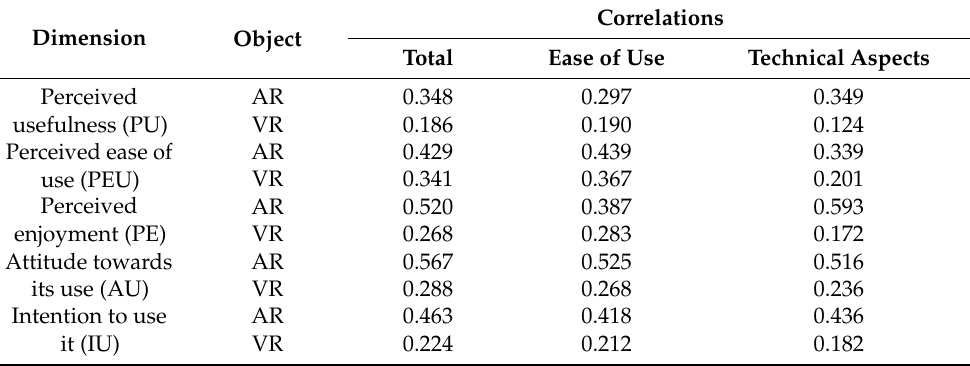
Table 12. Pearson’s correlation coefficient between the scores achieved for both instruments. Source: developed by the